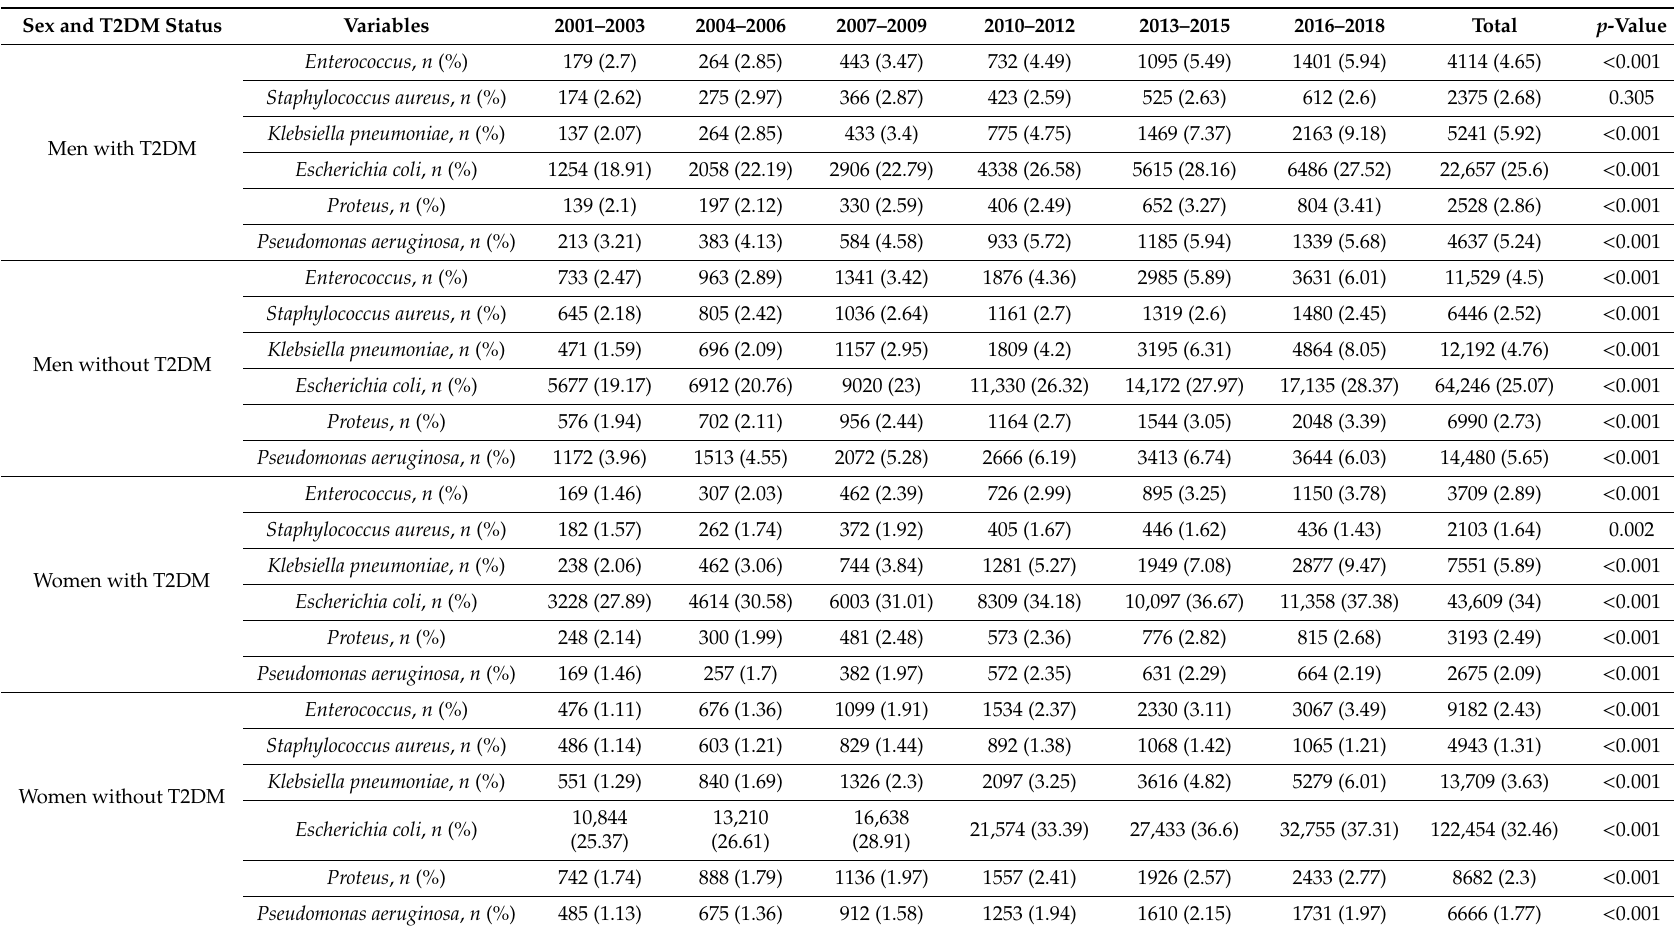
Table 3. Isolated pathogens codified in hospital admissions among patients with a principal diagnosis of urinary tract infection in Spain, 2001–2018, according to diabetes status and